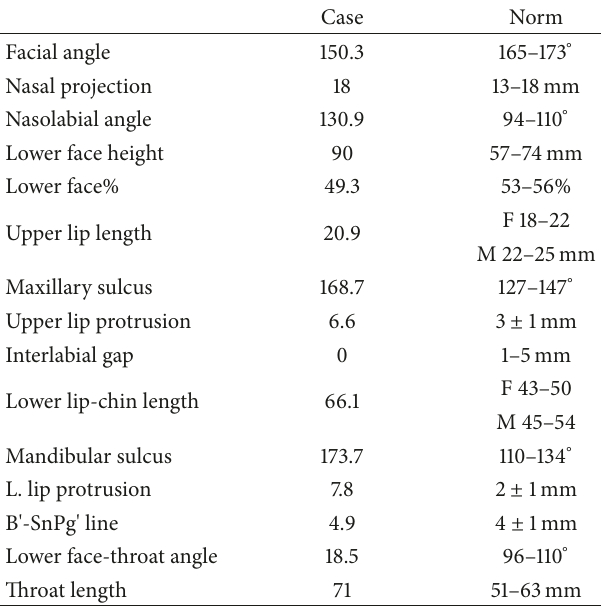
Table 3: Arnett-Bergman soft tissues analysis after